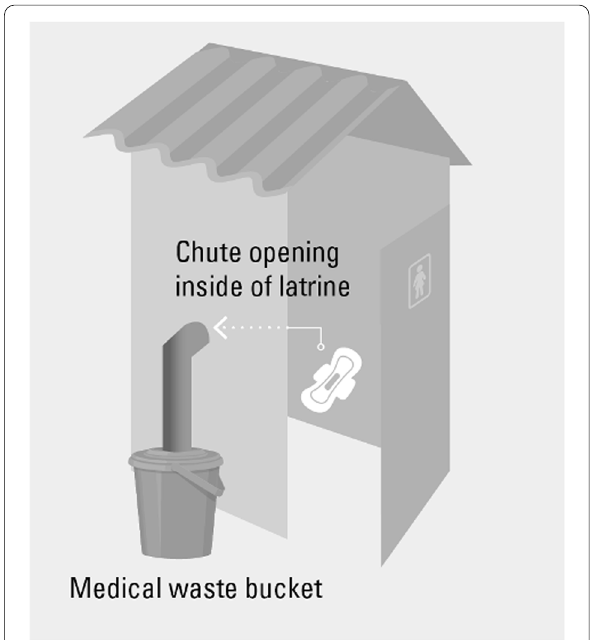
Fig. 1 An example of a chute disposal